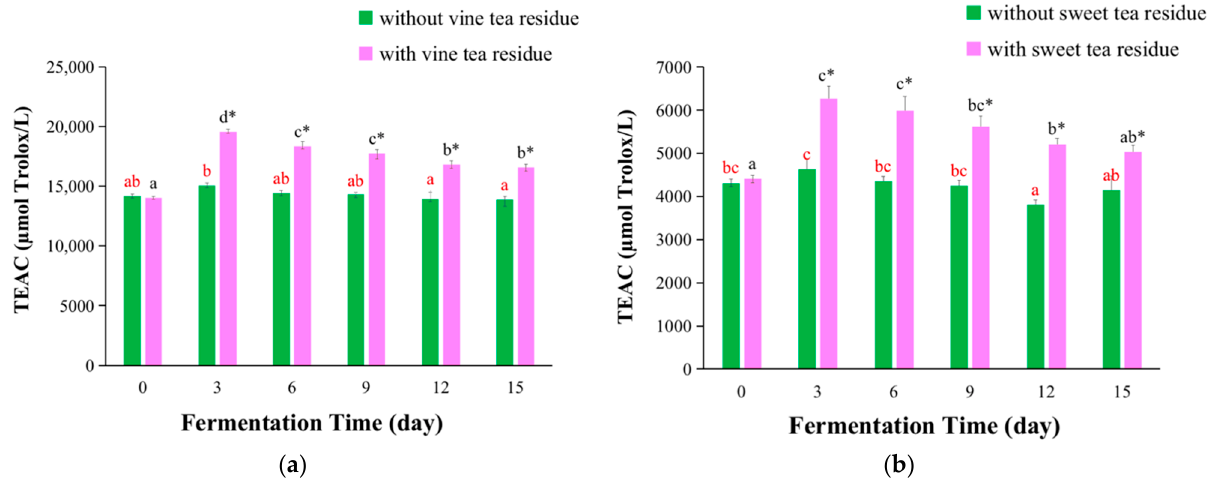
Figure 3. Changes of TEAC values of kombucha beverages at different fermentation time. ( a ) TEAC values of kombucha from vine tea; ( b ) TEAC values of kombucha from sweet tea. The different red letters indicated that kombucha fermentation without tea residues at different fermentation time were significant differences ( p < 0.05), and the same red letter indicated no significant difference ( p > 0.05). The different black letters indicated that kombucha fermentation with tea residues at different fermentation time had significant differences ( p < 0.05), and the same black letter indicated no significant difference ( p > 0.05). * Indicated that there was a significant difference between the kombucha fermentation with tea residues and kombucha fermentation without tea residues at the same fermentation time ( p < 0.05).